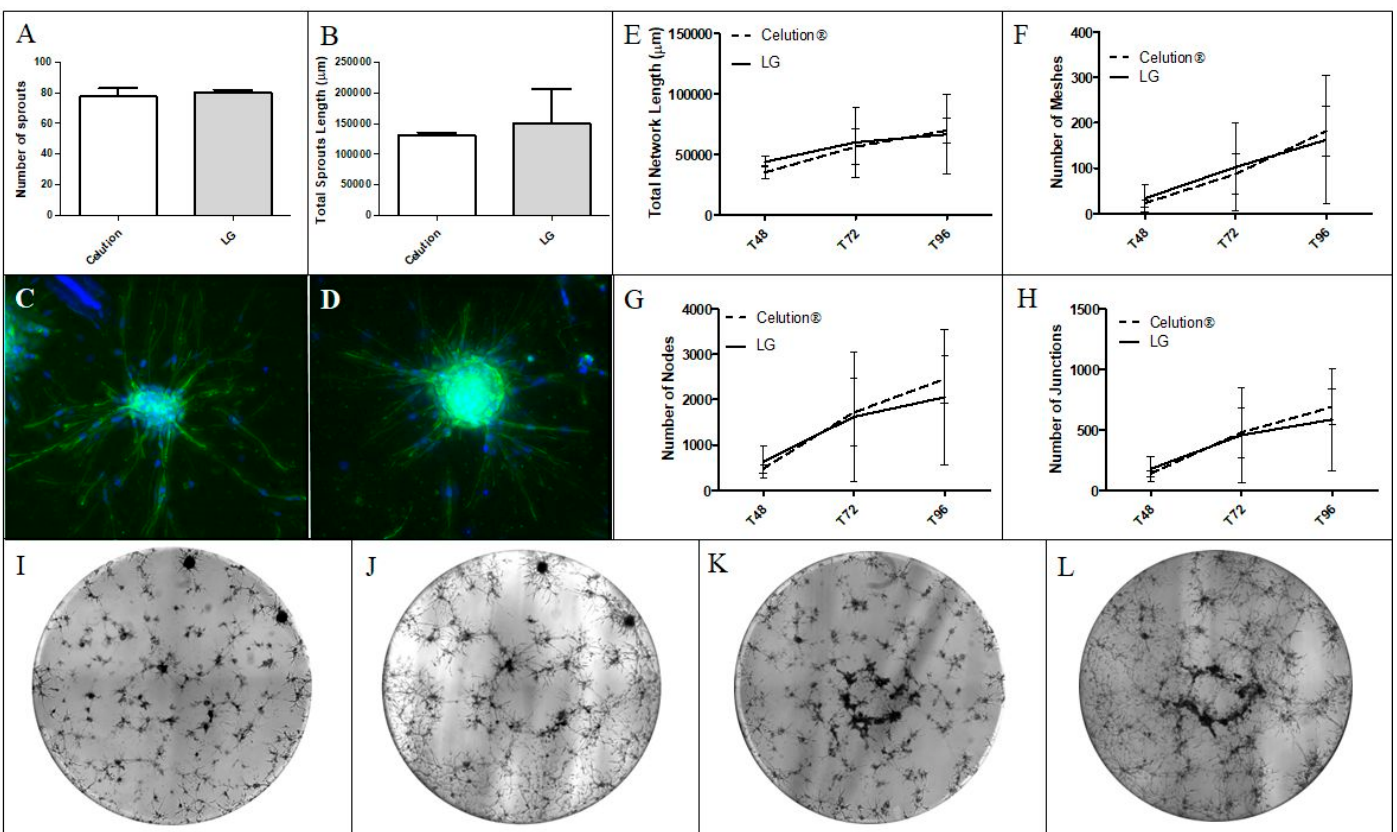
Figure 6. Representative experiment of the spheroid-based assay and pseudotube formation in Matrigel of SVF produced with the LG or reference protocols. SVF was produced from the same AT sample with both processes (n = 2). After 24 h of culture, spheroids were labeled with 6-diamidino-2-phenylindole (DAPI) (nucleus) and phalloidin (actin cytoskeleton), which allowed measurement of ( A ) the number of sprouts and ( B ) total sprout length in µ m. Representative pictures of one spheroid of the ( C ) Celution group and ( D ) the LG group were taken at 20 × magnification. Evolution of the network was followed after seeding 20,000 cells per well coated with Matrigel. Several parameters were evaluated: ( E ) total network length, ( F ) number of meshes, ( G ) number of nodes, and ( H ) number of junctions. Representative images of pseudotube formation by ( I ) Celution SVF at 72 h and ( J ) 96 h post seeding, and by ( K ) LG SVF at 72 h and ( L ) 96 h post seeding were taken at 4 ×